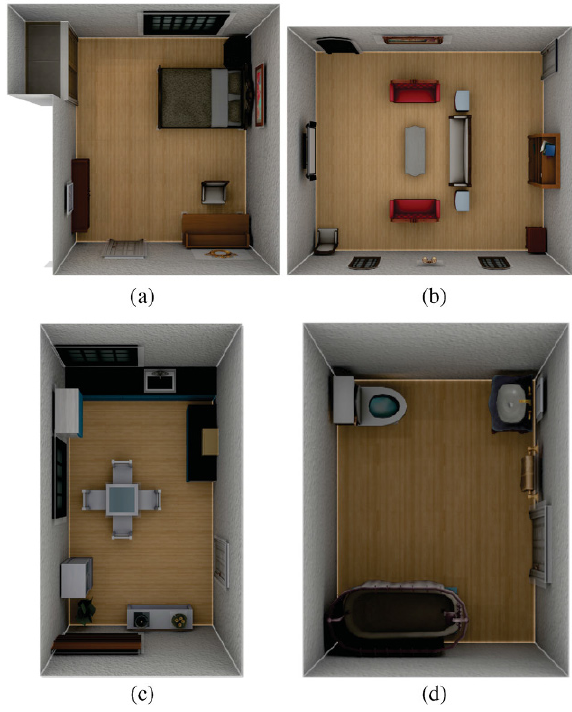
Fig. 7 Some rooms generated by automatic indoor design. Each case takes a different room type vector T as input, to generate (a) a bedroom, (b) a living room, (c) a dining room integrated with a kitchen, and (d) a